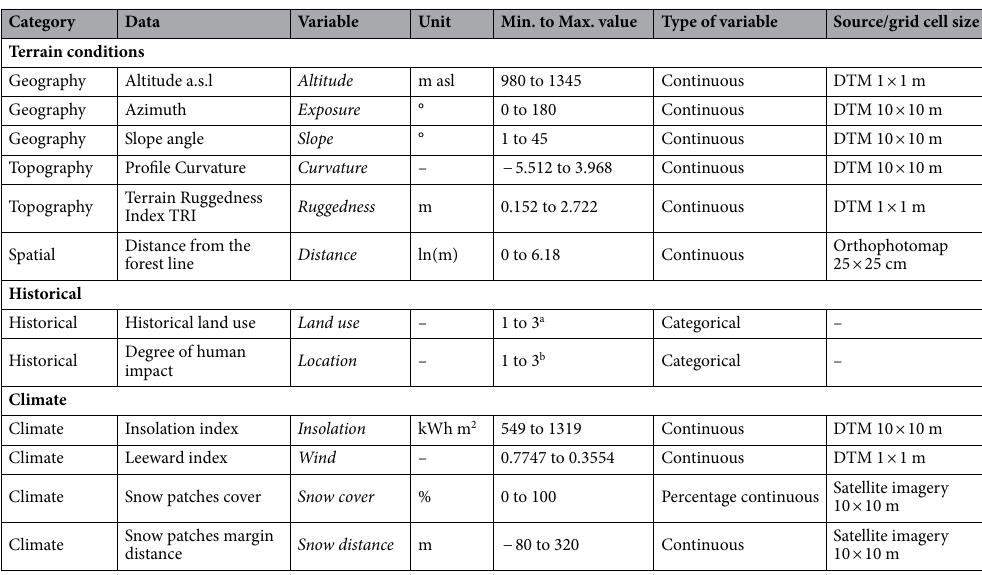
Table 1. List of driving factors in this study. a 1—pastures, 2—partially wooded meadows, 3—meadows. b 1— Smerek, Połonina Caryńska, Połonina Wetlińska, 2—Tarnica&Halicz, 3—Mała&Wielka